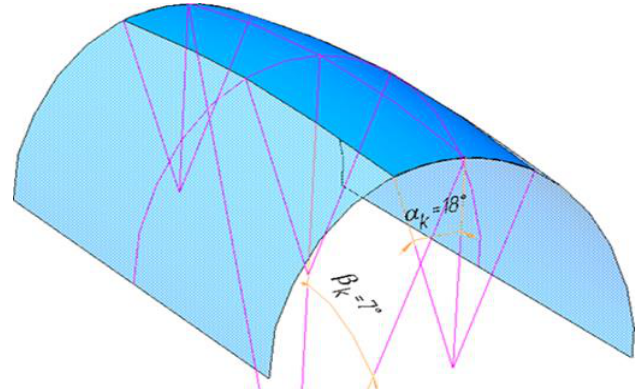
Figure 3. The central section of the shell